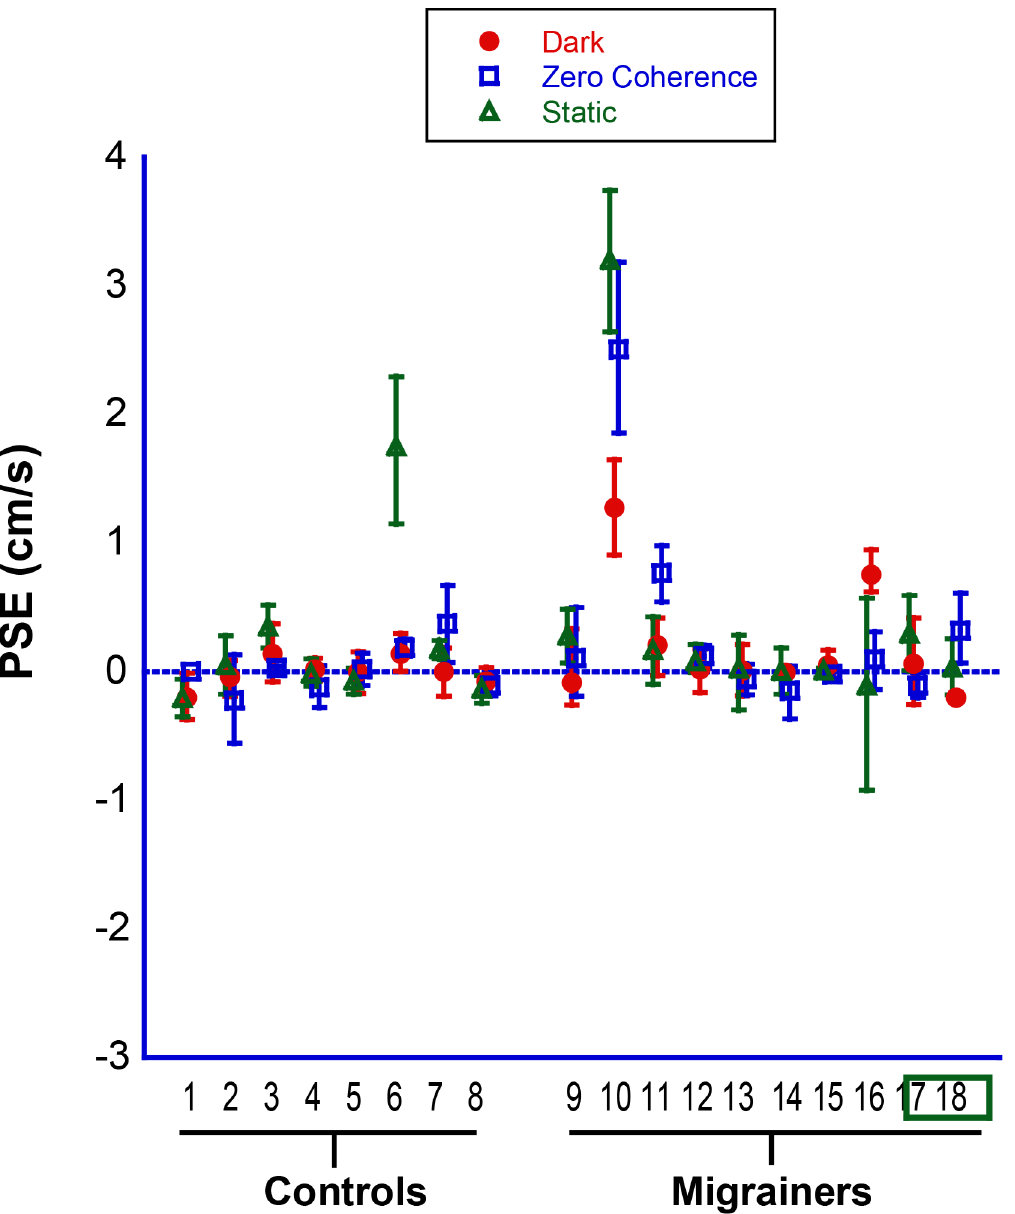
Fig 9. - Individual Data for Experiment 2. Control Trials . Platform motion in darkness (red circles). Viewing a static visual stimulus (green triangles). Viewing a 0% coherence visual stimulus (blue squares). Error bars represent 95% CI.